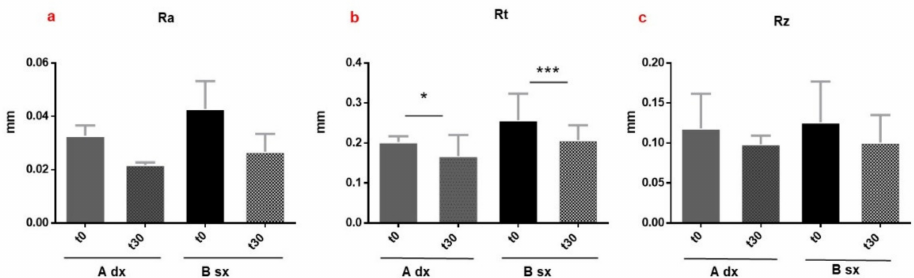
Figure 12. Average of roughness parameters (( a ), Ra, the mean roughness of the skin; ( b ), Rt, the maximum relief height, and ( c ), Rz, average maximum profile height). Results shown are mean ± SD of three determinations for each volunteer at different measurement times. Data were analyzed by two-way RM (repeated measures) ANOVA (analysis of variance), followed by a Bonferroni adjustment. Data were significant different p value < 0.05 ( p < 0.05 *; p < 0.001